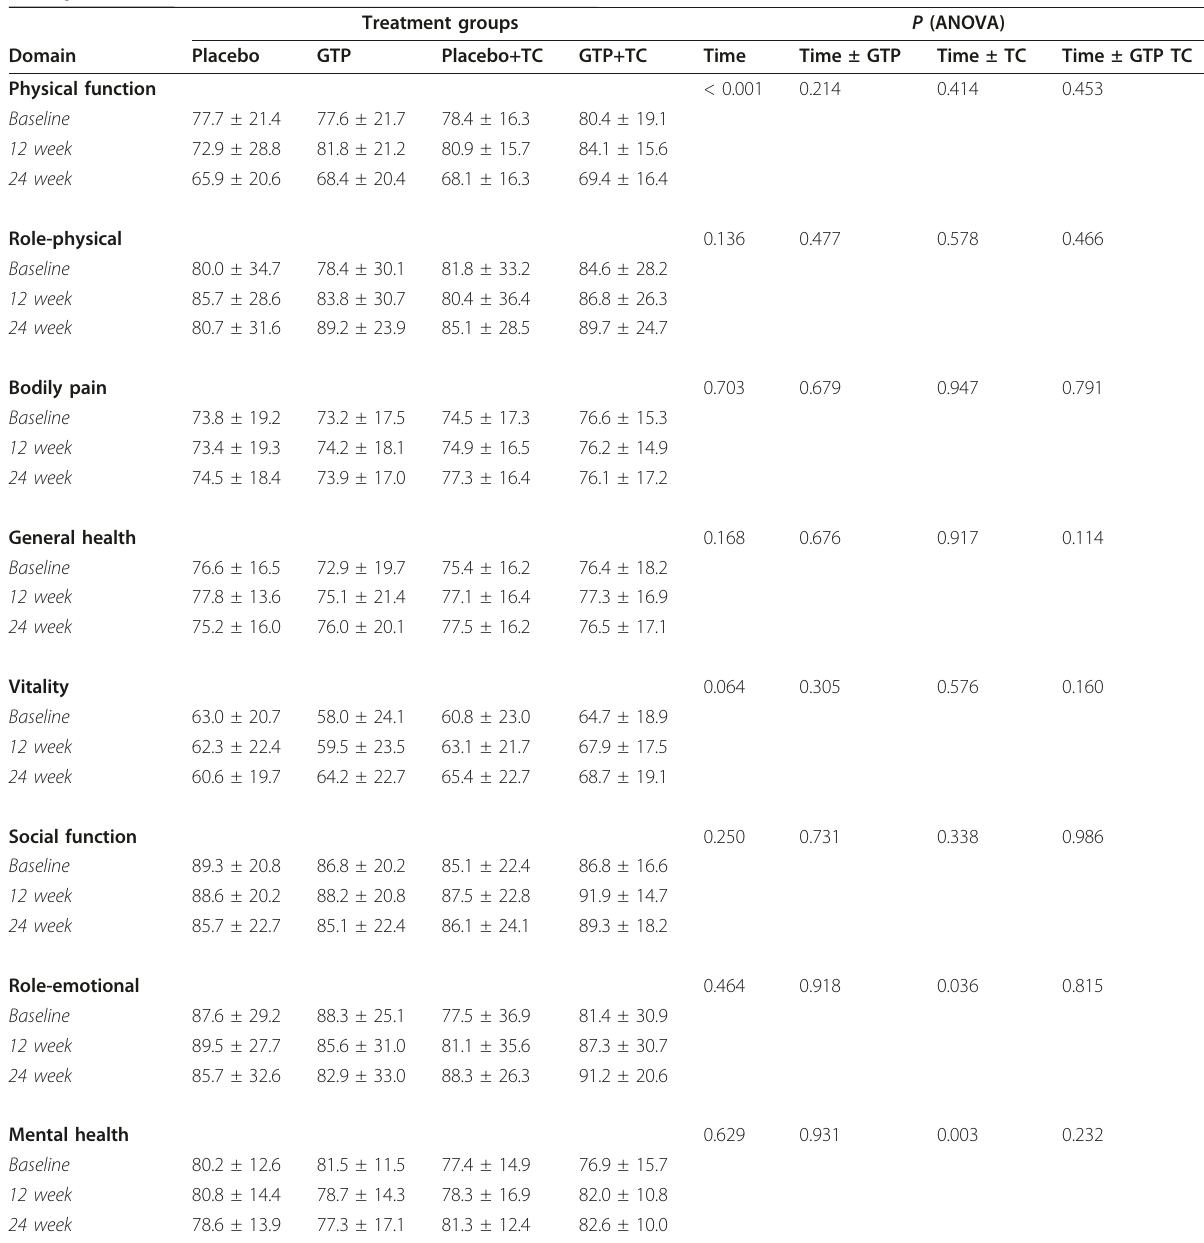
Table 3 Effect of green tea polyphenols supplementation and Tai Chi exercise on quality of life in postmenopausal osteopenic women Treatment